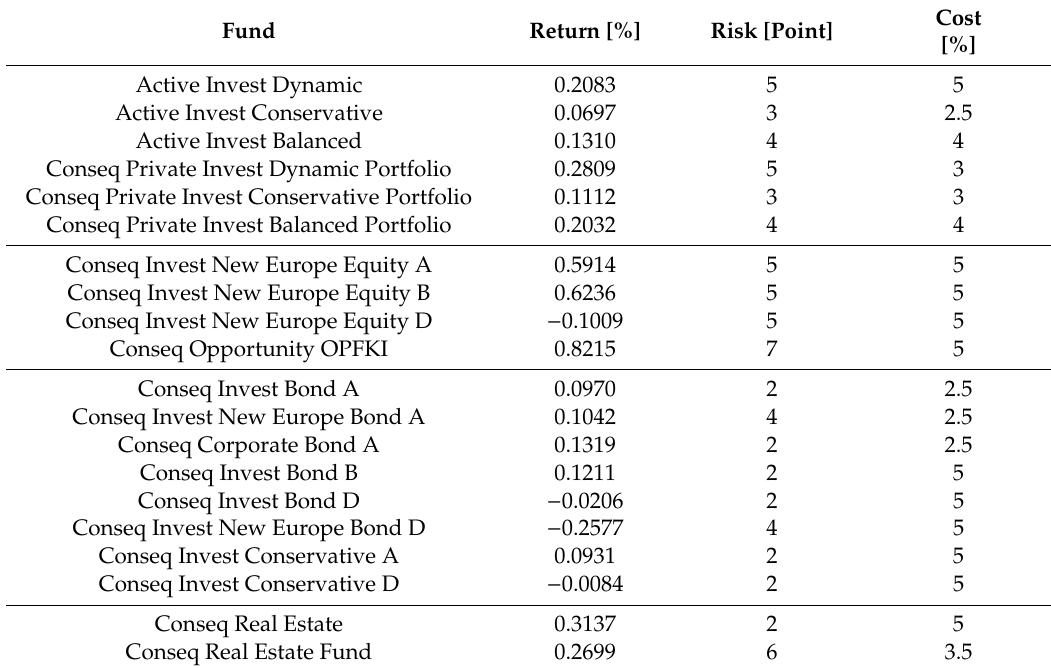
Table 1. Open unit trusts and their